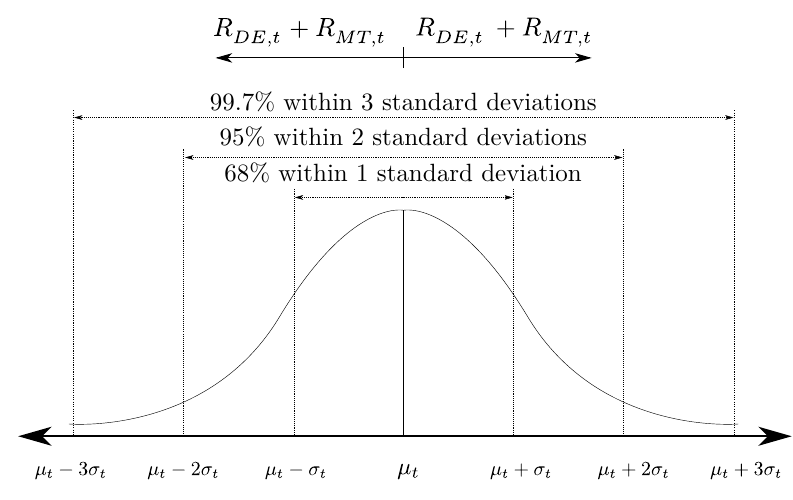
Figure 2. Normal distribution of the demand estimation